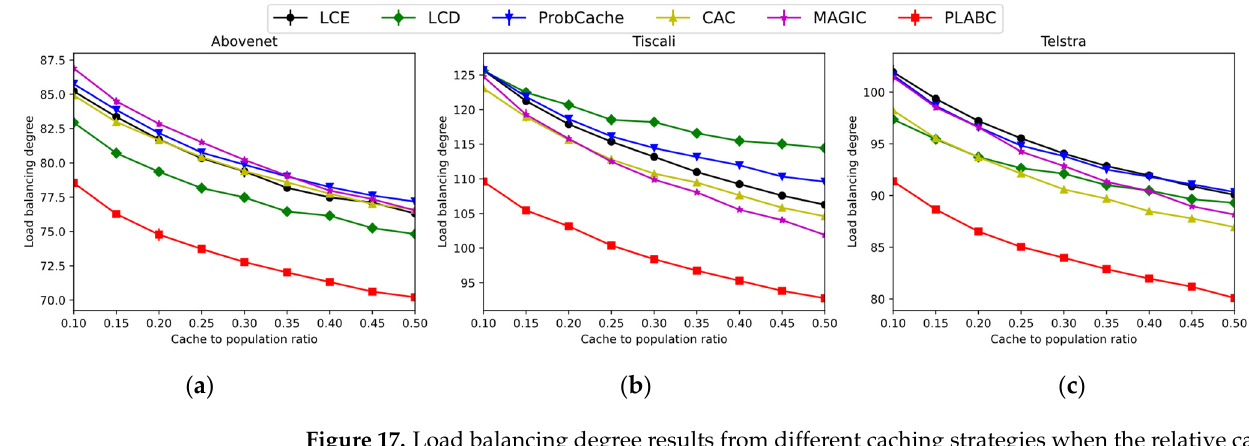
Figure 17. Load balancing degree results from different caching strategies when the relative cache size varies under topology: ( a ) Abovenet; ( b ) Tiscali; ( c ) Telstra.